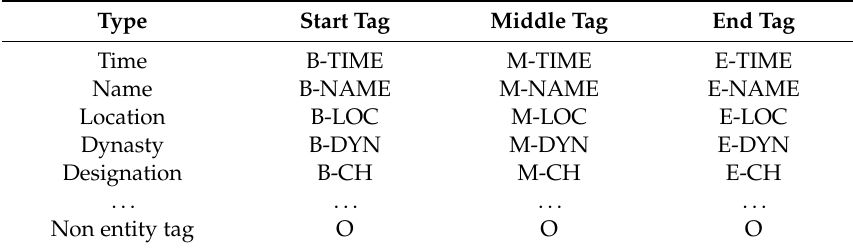
Table 1. Labeling strategy of